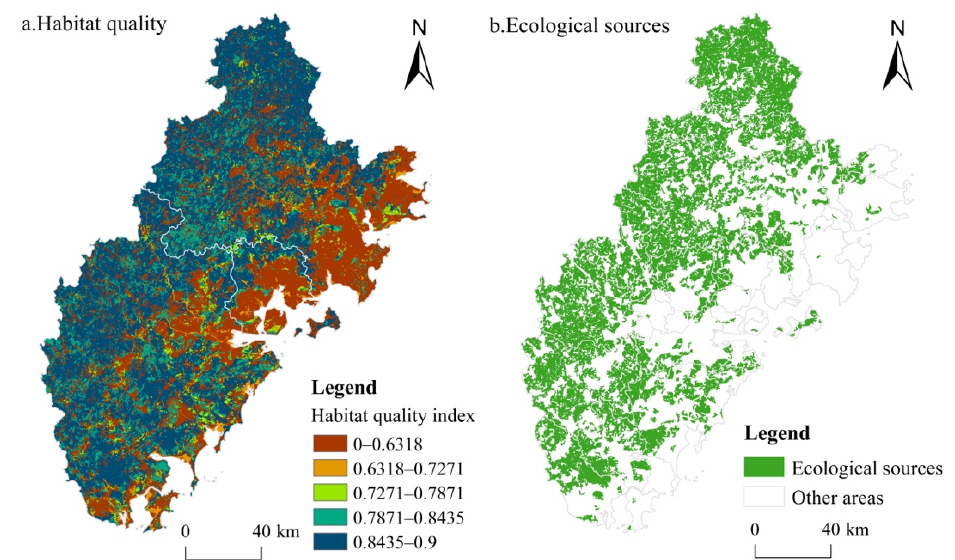
Figure 3. Spatial distribution map of ecosystem quality and ecological sources: ( a ) ecosystem quality where high quality is represented by 1 and low quality is represented by 0; ( b ) ecological sources (top three grades and ecosystem areas exceeding 2 km 2 were identified as ecological sources).